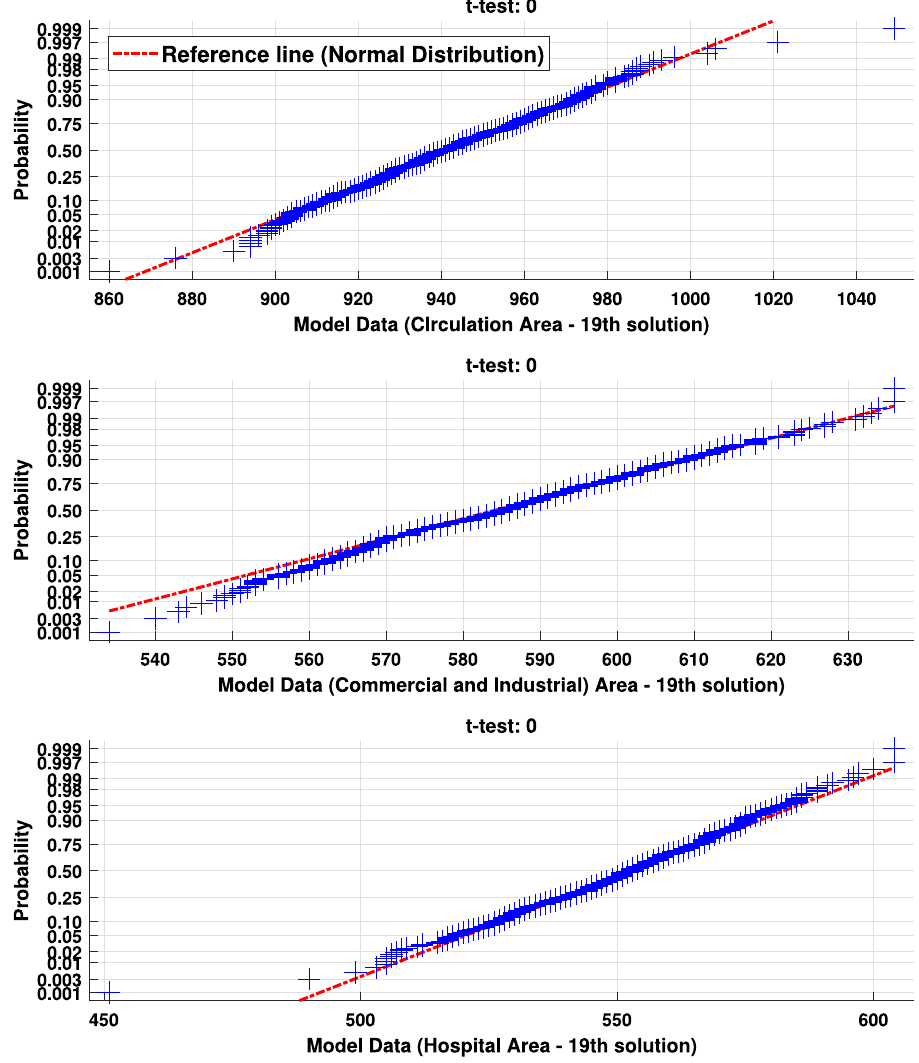
Figure 17. Student’s t-test applied on model data concerning agents’ weekly movement density per environment’s regions (Circulation, Commerce and Industry, and Hospital)—19th